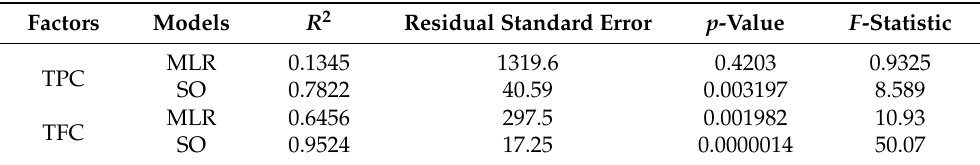
Table 2. Analysis of response surface data using multiple linear regression (MLR) and second-order (SO) for the total phenolic content (TPC) and total flavonoid content (TFC).